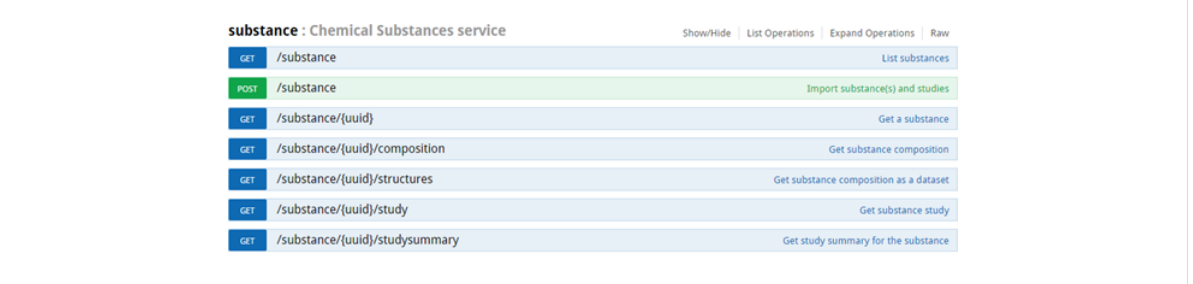
Figure 2: Top level substance API documentation. The “GET /substance” call is used to retrieve or search a list of NM, subject to multiple query para- meters defining the NM search. The “POST /substance” call is used to upload NM and study data in supported formats. The “/substance/{uuid}” call is used to retrieve the substance specified by its unique identifier. Each substance is identified with an unique identifier, generated or specified on import in the form of UUID. The rest of the calls allow to retrieve the component of the NM, the study data and a summary of the available data for the NM, grouped by endpoints.